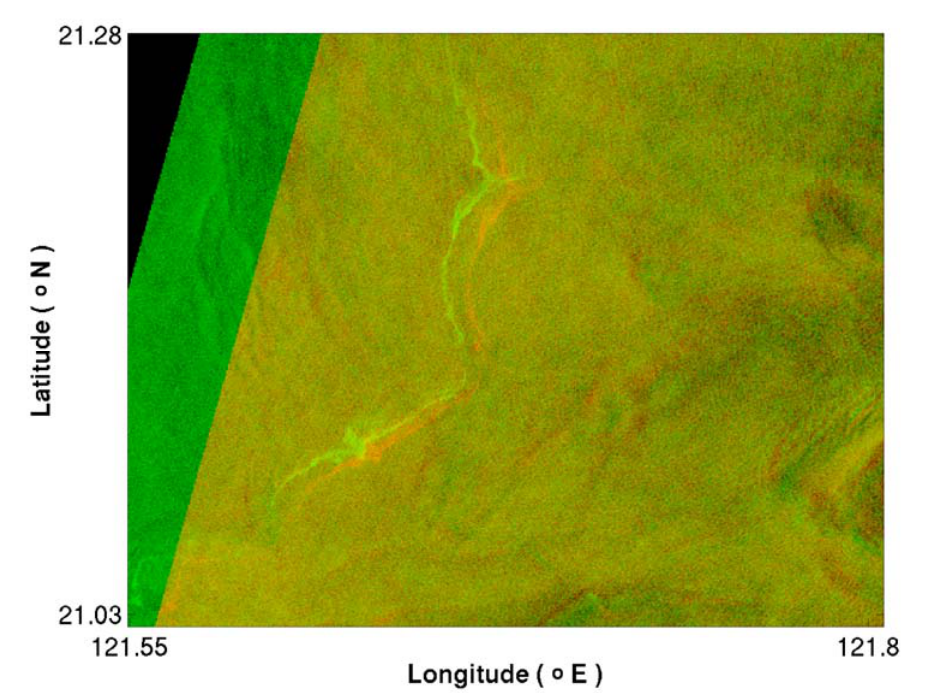
Figure 2. Overlay of two SAR subscenes of oil slick collected over the Luzon Strait near Philippines from ERS-2 (in green), and ENVISAT (in red) on April 27, 2005 separated by 28 minutes. The subscene coverage area is shown in the small green box in Figure